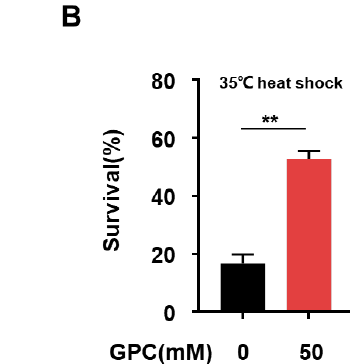
Table 2. Effect of GPC on the oxidative stress resistance in C. elegans .